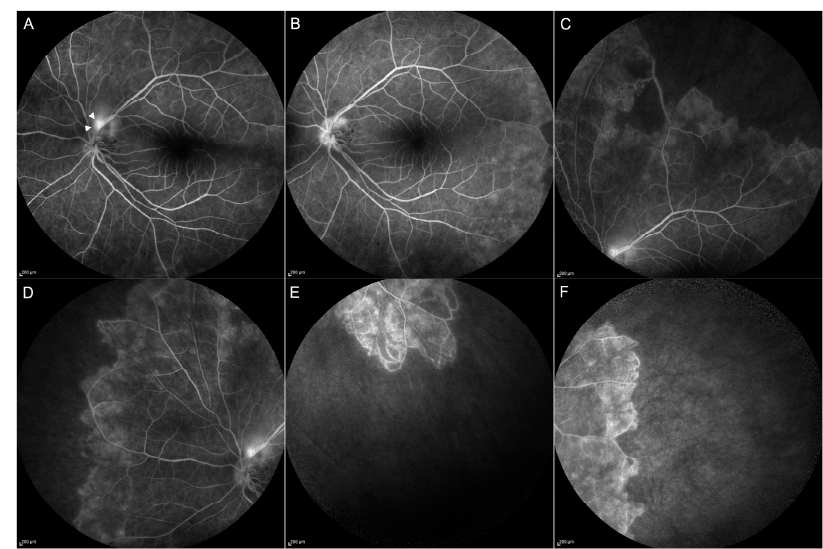
Figure 8. Case 3, Eales disease. Signs of vasculitis ( arrowheads ) are visible in the late phases of FA ( A ) with resolution after the therapy ( B ). Extended ischemic areas in the peripheral retina appear darker and without vascularization ( C–F ).